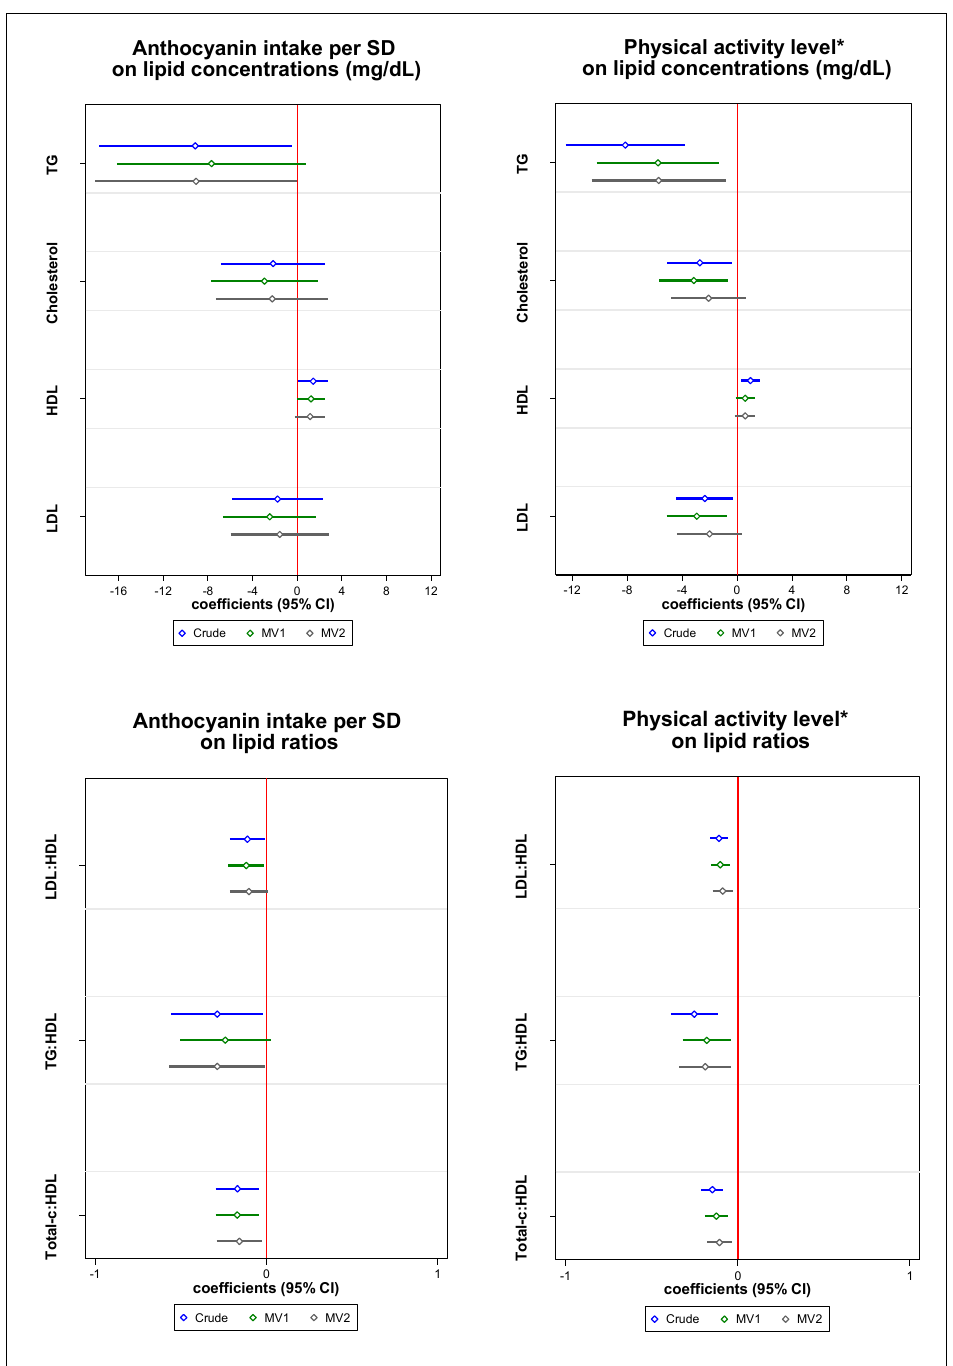
Figure 1. Independent associations ( β , 95% CI) of anthocyanin intake (SD) and physical activity level with lipid concentrations (mg/dL) and lipid ratios. * Physical activity was assessed using a scale of 0–7 representing levels of physical activity ranging from none to running > 10 miles/wk or spending > 3 hrs/wk in comparable physical activity (Table S2). MV1: multivariable model 1 adjusted for age, sex, BMI, smoking status, education level, marital status, prevalent hypertension, dyslipidemia, and type 2 diabetes. MV2: multivariable model 2 adjusted for age, sex, BMI, total energy intake, mMDS, smoking status, education level, marital status, multivitamin use, supplement use, sleep, prevalent hypertension, dyslipidemia, and type 2 diabetes. CI: confidence intervals, HDL: high density lipoprotein cholesterol, LDL: low density lipoprotein cholesterol, SD: standard deviation, TG: triglycerides, Total-c: total cholesterol. Table S1 shows β coe ffi cients (95% CI) and p -vales of independent associations for all linear regression